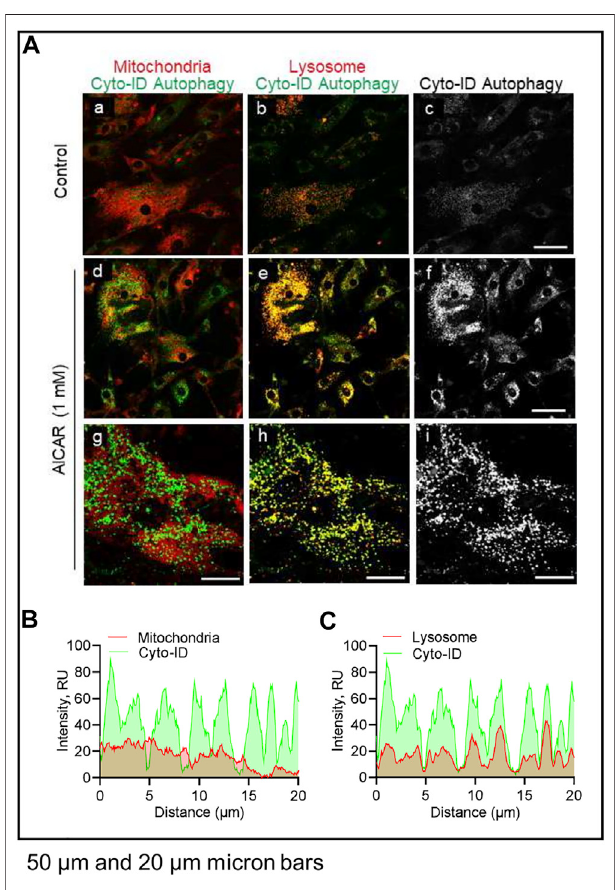
FIGURE 9 | Effects of AICAR on localization of intracellular autophagic vacuoles in vitro . Luteal cells were stimulated with AICAR (1 mM) for 3 h and subject to confocal microscopy. (A) Representative micrographs showing the effects of AICAR on autophagy in luteal cells. From left to right; Merge of Mitochondria with Cyto-ID autophagy (Mitotracker; panels a, d and g), Merge of Lysosomes with Cyto-ID autophagy (Lysotracker; panels b, e and h) and Cyto-ID (white; panels c, f and i) obtained from cells treated (from top to bottom) with vehicle control or AICAR (1 mM). White box represents localization of intensity pro fi le. (B) Intensity pro fi les illustrating the colocalized overlapofmitochondria(red)andCyto-IDreagent(green). (C) Intensitypro fi les illustrating the colocalized overlap of lysosomes (red) and Cyto-ID reagent (green). Micron bars represents 50 and 20 µm.